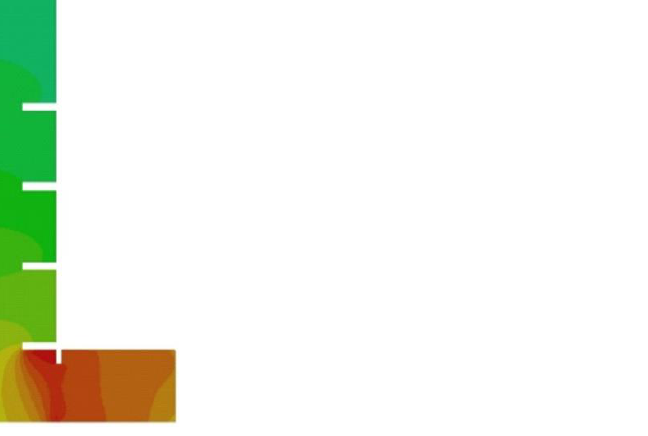
Figure 8. Temperature distribution for a closed building. Temperature was measured in (K).